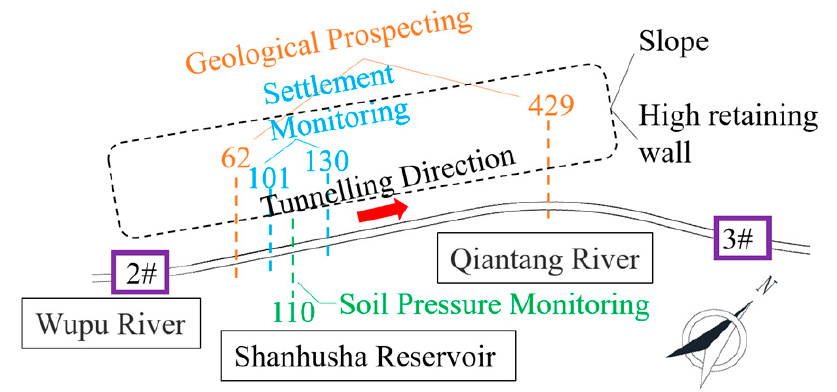
Figure 1. Project Overview.